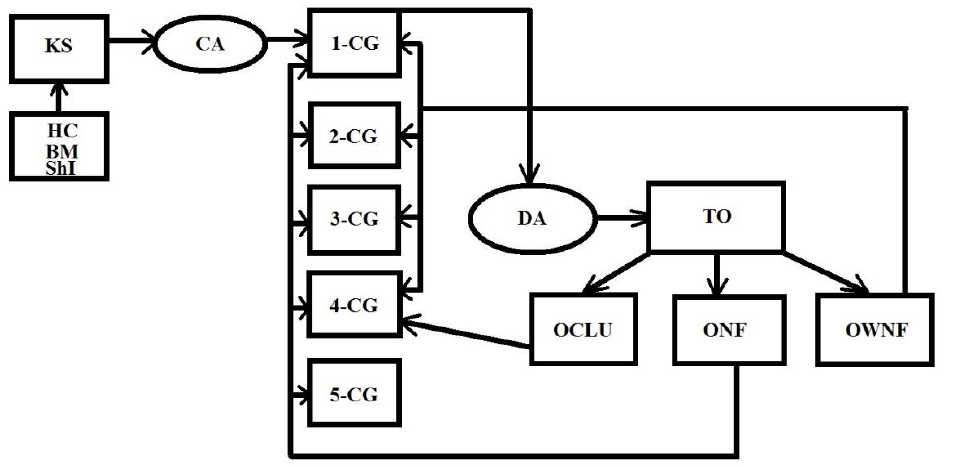
Figure 2. Schematic of cluster analysis of key sites. The direction of the object clustering algorithm corresponds to arrows; square-shaped blocks—input and output results; oval-shaped blocks—data analysis operations; Alphabetic notations in the diagram: ShI. Shannon Index; BM—Herbaceous Plant Biomass, t/ha; HC. Humus Content, %; KS. Key Sites; CA. Cluster Analysis; 1-CG. 1st Cluster Group; 2-CG. 2nd Cluster Group; 3-CG. 3rd Cluster Group; 4-CG. 4th Cluster Group; 5-CG. 5th Cluster Group; DA. Dimensional Analysis; TO. Type of Overgrowth; OCLU. Overgrowth Associated with A Change in Land Use; ONF. Overgrowth Associated with Nearby Forest; OWNF. Overgrowth without Nearby Forest.